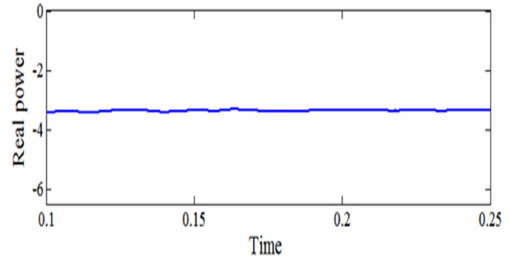
Figure 40. Real power from bidirectional converter.